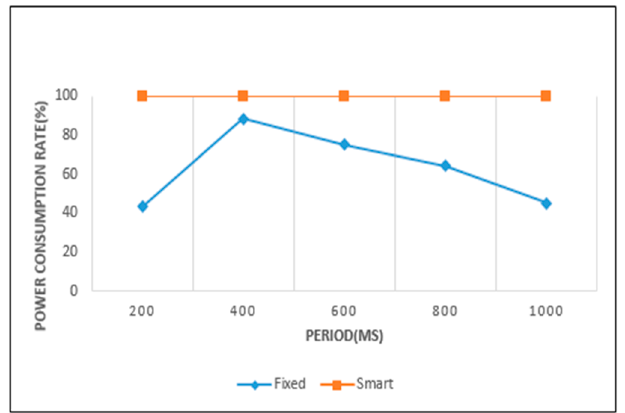
Figure 15. Power consumption of ultrasonic sensor. Sensors 2019 , 19 , x